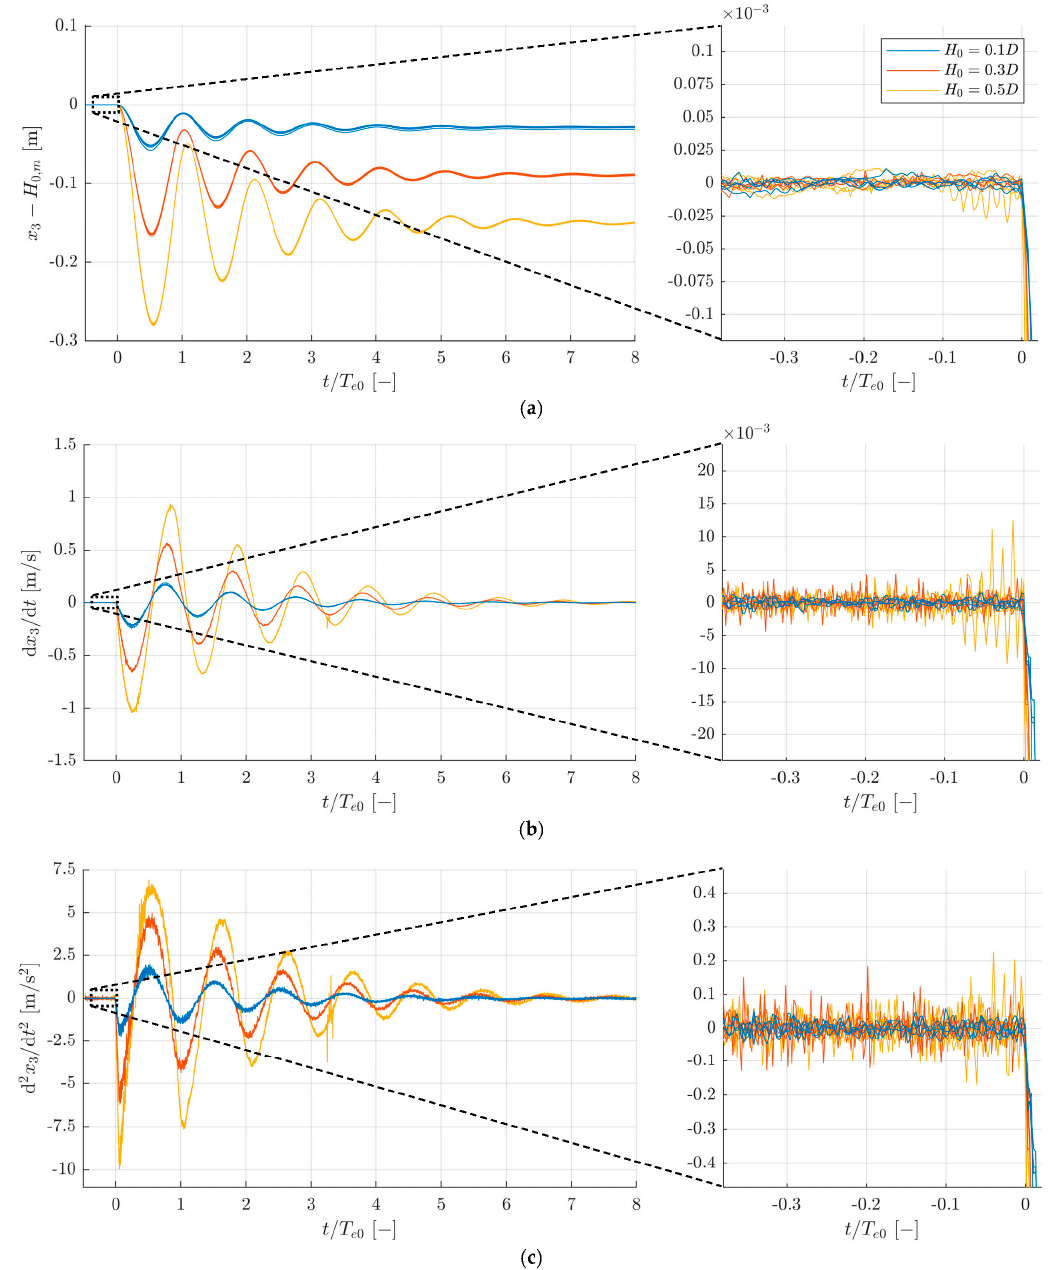
Figure 17. Position ( a ), velocity ( b ), and acceleration ( c ) time series with zooms of the limits −0.3 < 𝑡 𝑇 (cid:3032)(cid:2868) ⁄ < 0 .